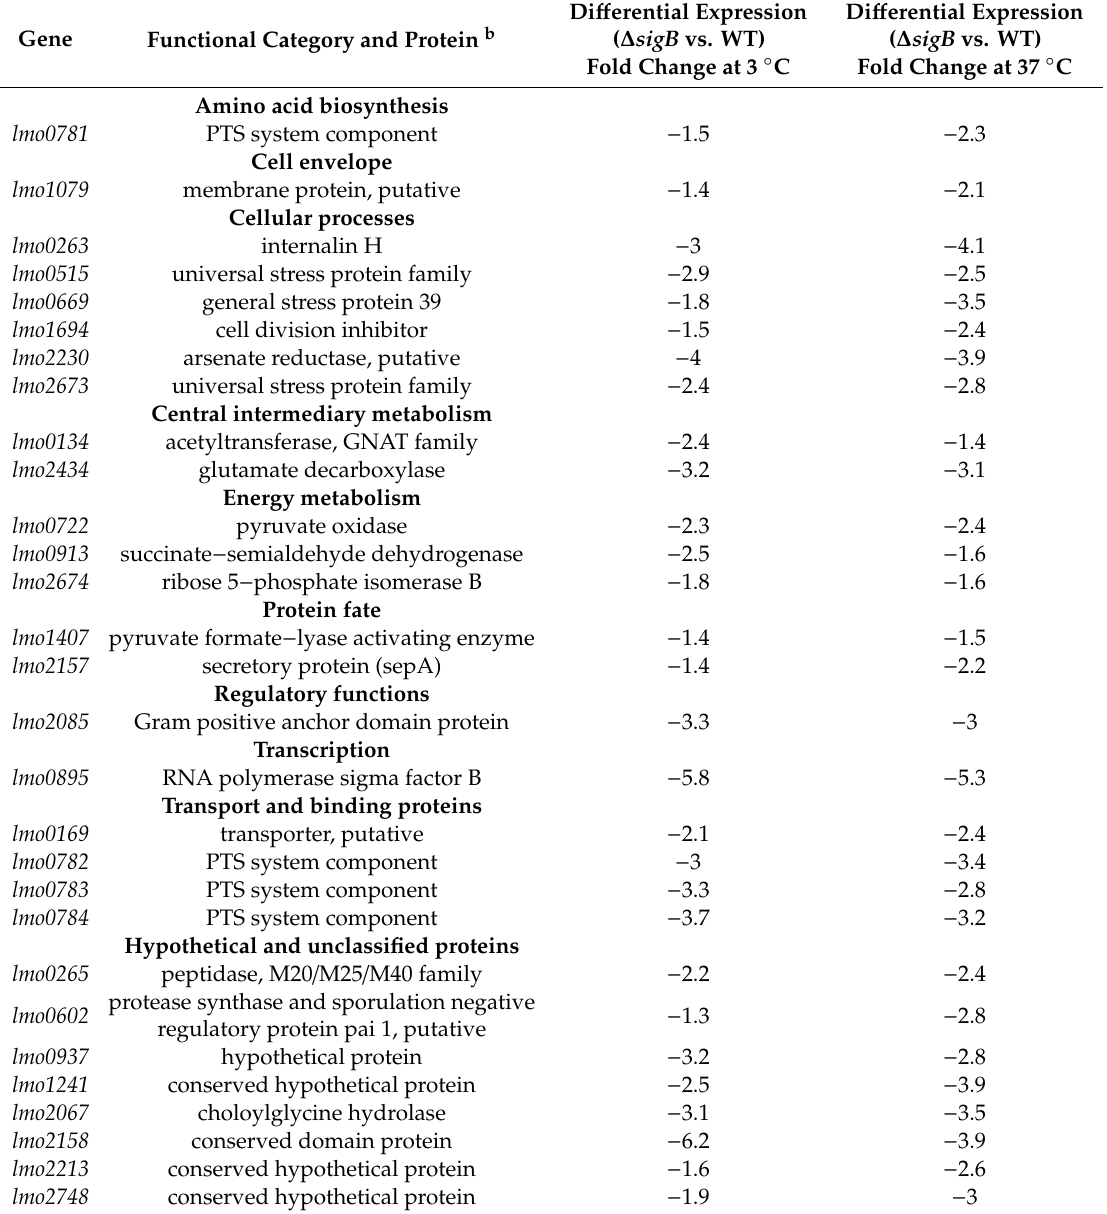
Table 3. Genes that were down-regulated during exponential growth of Listeria monocytogenes ∆ sigB in BHI at 3 and 37 ◦ C a